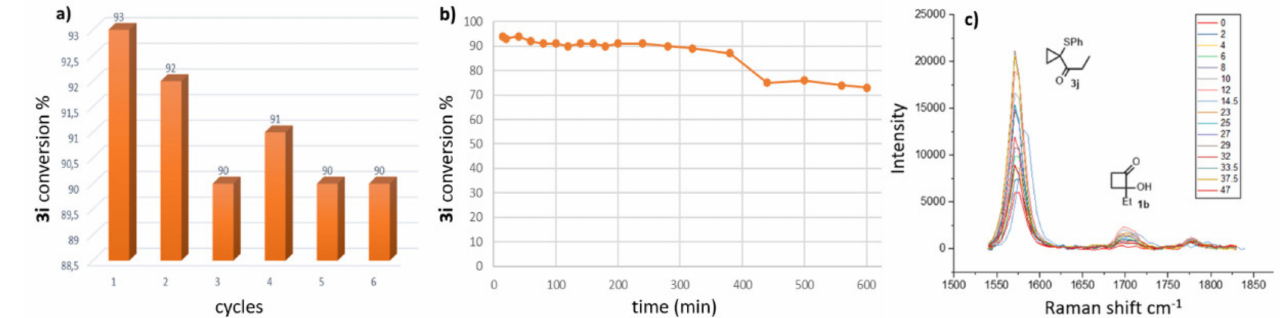
Figure 4. ( a ) Evaluation of the catalytic activity of the AR-35 packed column in the reaction between 1b and 2a over six cycles. ( b ) Evaluation of the catalytic activity of the AR-35 packed column in the reaction between 1b and 2a over ten hours. ( c ) Raman acquisitions during the continuous-flow synthesis of 3j